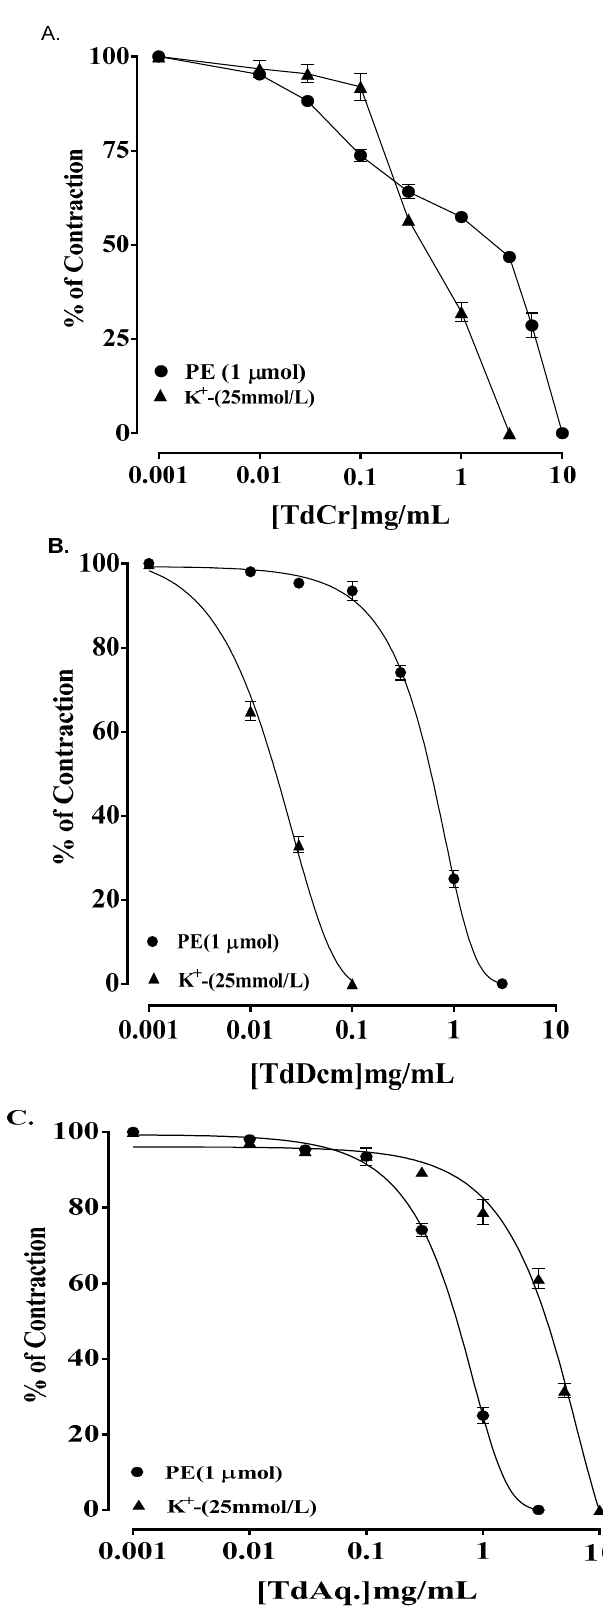
Figure 9. Concentration-response graphical presentation of ( A ) (TdCr), ( B ) TdDcm, and ( C ) TdAq on K + (25 mmol / L) and phenylephrine (1 µ mol / L) provoked contractions of isolated aortic ring preparations. Values shown as mean ± SEM, n = 5.